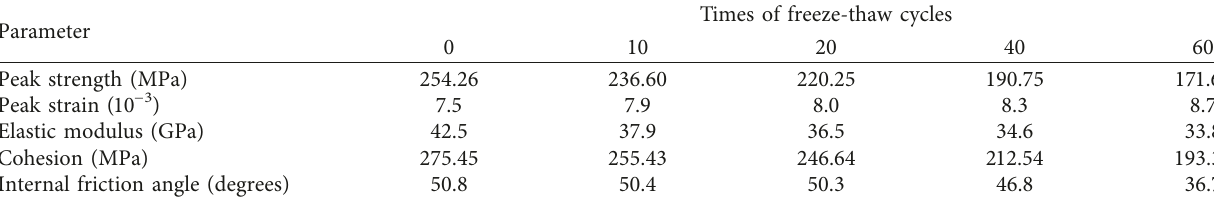
Table 2: Three-dimensional axial compression test parameters of tuffaceous sandstone under different freeze-thaw cycles.